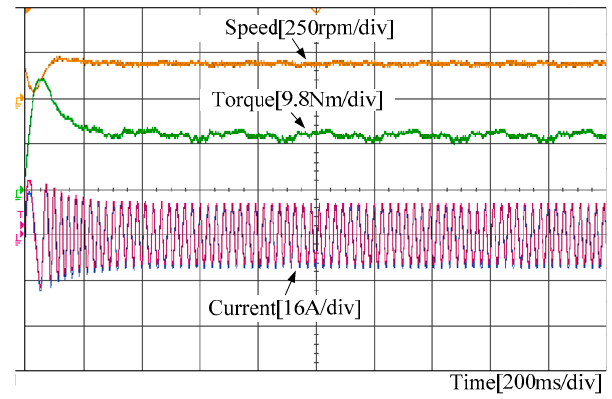
Figure 15. Measured transient waveforms during start-up process.